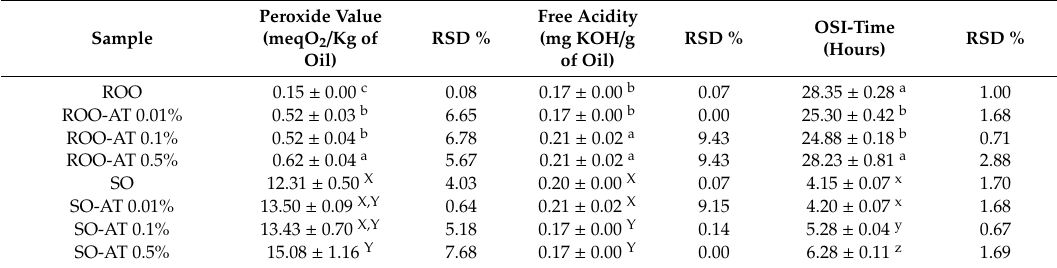
Table 2. Results of peroxide value, free acidity, and OSI-time for refined olive oil (ROO) and sunflower oil (SO) with α -tocopherol (AT) added. Data are presented as mean ± standard deviation and coe ffi cient of variation